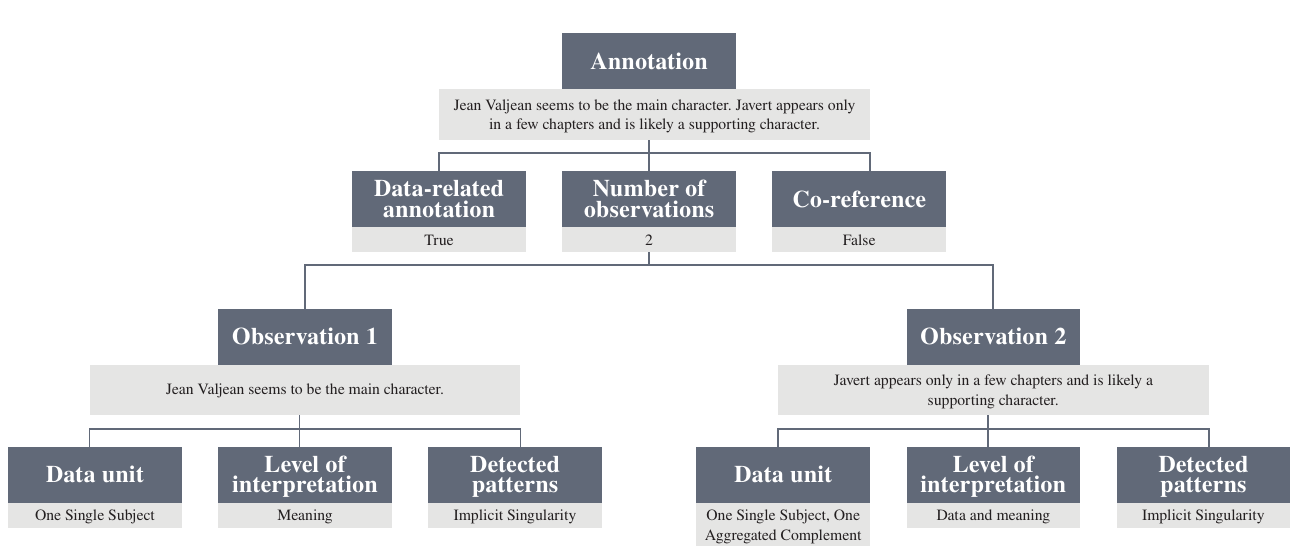
Figure 1. An example illustrating how the classification framework works.